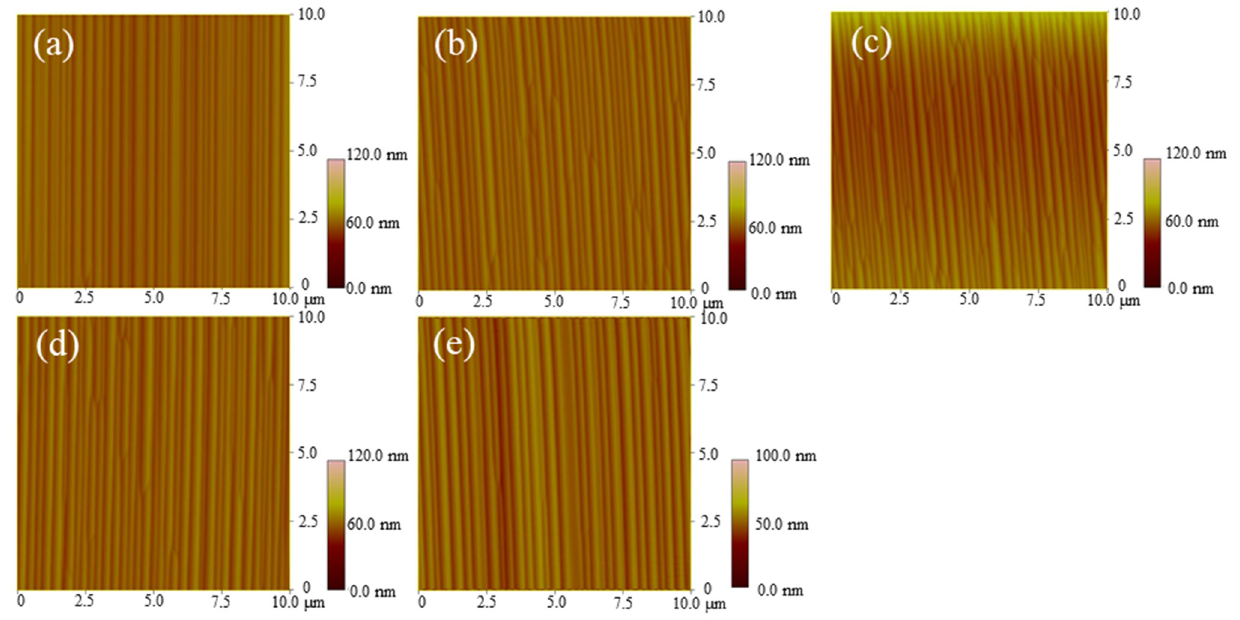
Figure 12. AFM images of 4H-SiC wafers with Si/H ratios of ( a ) 0.08%, ( b ) 0.10%, ( c ) 0.12%, ( d ) 0.13%, and ( e ) 0.15%.